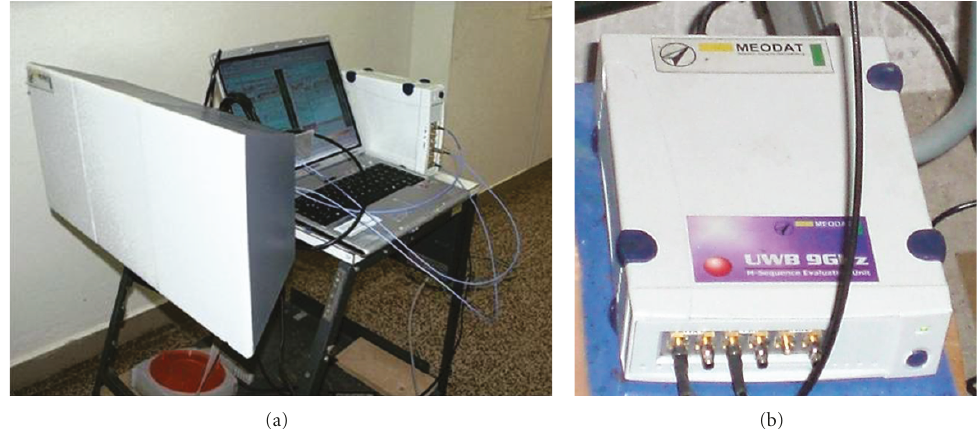
Figure 1: Experimental M-Sequence UWB radar system: (a) three horn antennas, PC unit and a radar device, (b) detail of the radar